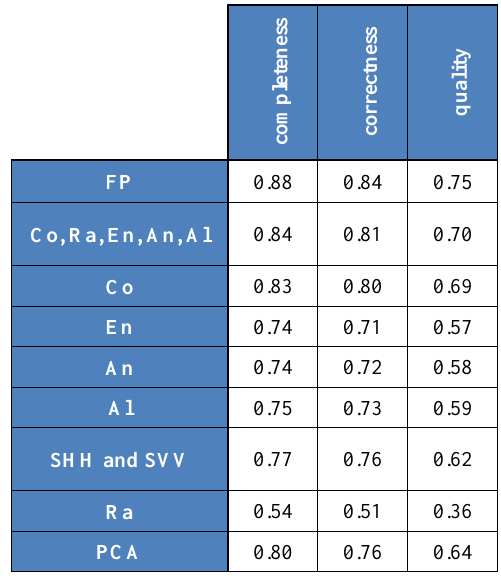
Table 3: completeness, correctness and quality assessment of different band combinations for the subset area of the year 2012 The assessment was repeated for the year 2013 with only the full parameters case and the results are shown in Figure 5 and Table 4.